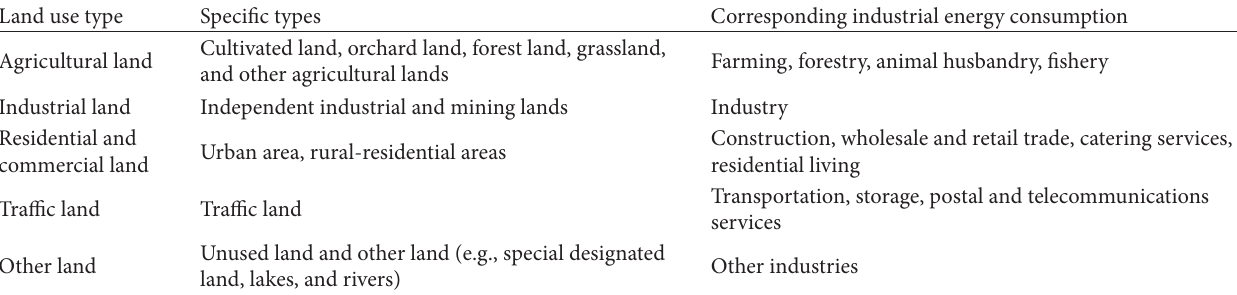
Table 1: Classification of land use types and their corresponding relationship with industrial energy